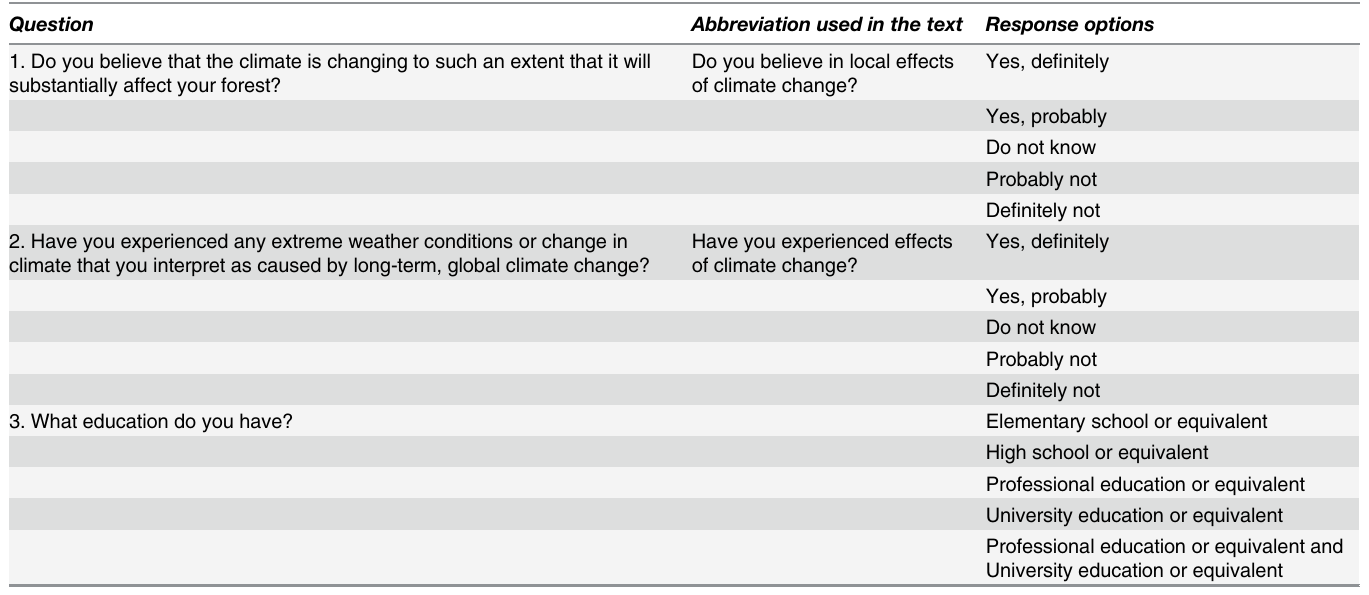
Table 1. Questions assessing respondents ’ risk perceptions relating to climate change and education, and response